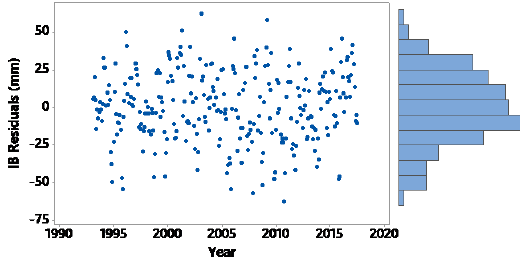
Fig. 8. IB residuals in mm. RMSE of the residuals is 23.5 mm.